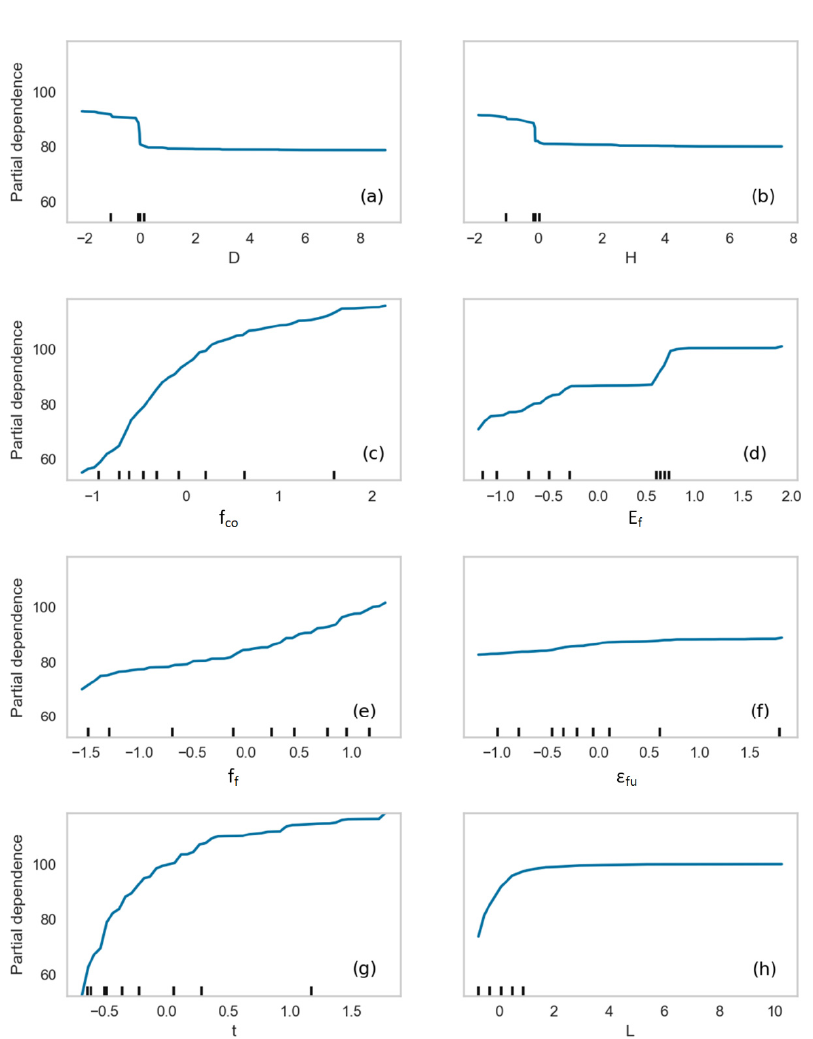
Figure 2. Partial dependence plots, presenting the f cc dependence on each one of the eight input variables ( a – h